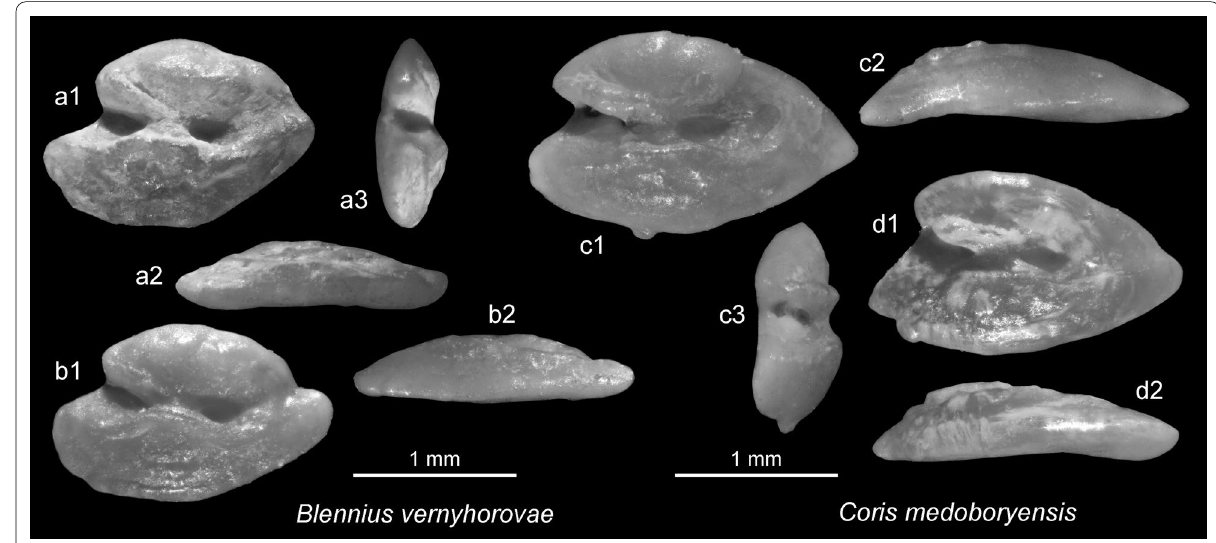
Fig. 8 Otoliths of Blenniidae and Labridae: a , b Blennius vernyhorovae n. sp., a holotype, NMNHU-P PI 2547, Mlyntsi, b (reversed) paratype, Kozatskyi Yar, NMB P1205. c , d Coris medoboryensis n. sp., c holotype, NMNHU-P PI 2551, Kozatskyi Yar, d (reversed) paratype, Mlyntsi, NMB